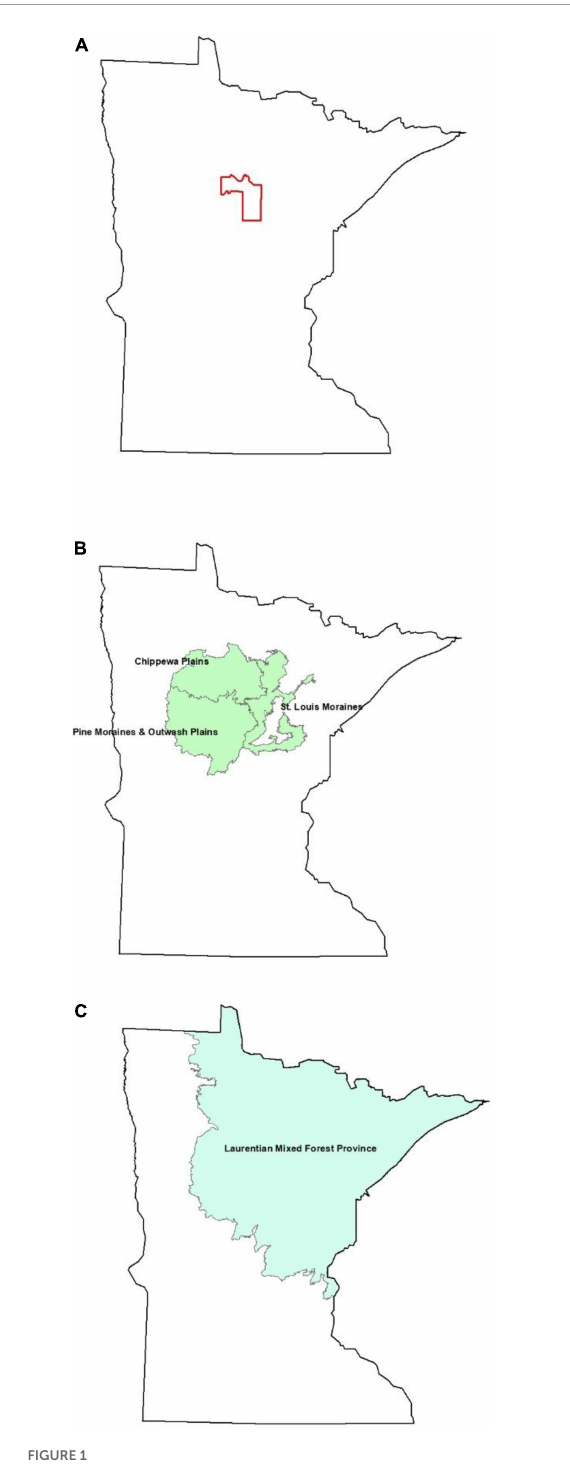
FIGURE1 Estimates of the abundance of tree stems in three forest successional classes that were suitable for nesting wood ducks in (A) the ecological province that contained the study area, (B) three ecological subsections that intersected the study area, and (C) a North central MN, United States study